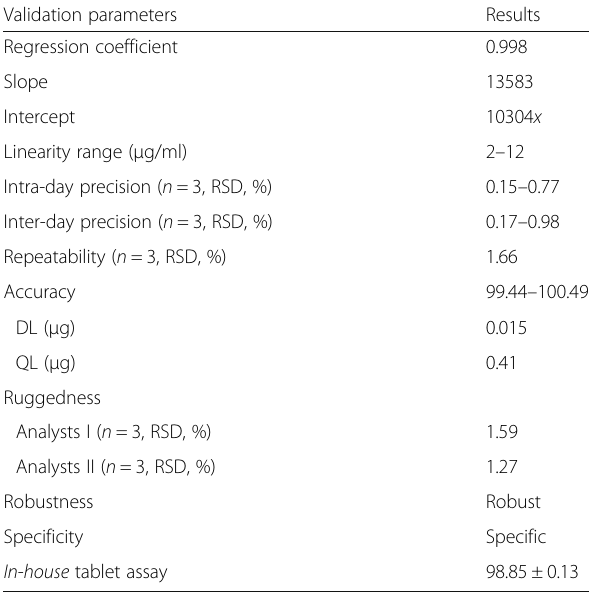
Table 5 Summary of regression, validation, and in - house tablet assay parameters for proposed RP-HPLC-PDA method Validation parameters